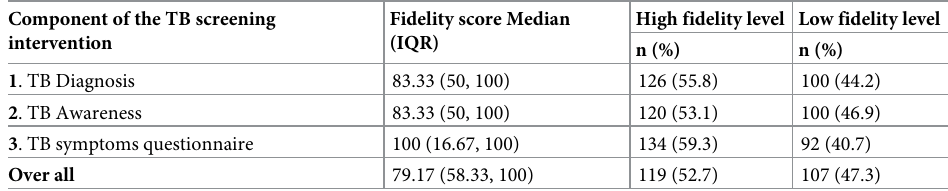
Table 4. Summary statistics of the provider fidelity scores by the components. Component of the TB screening